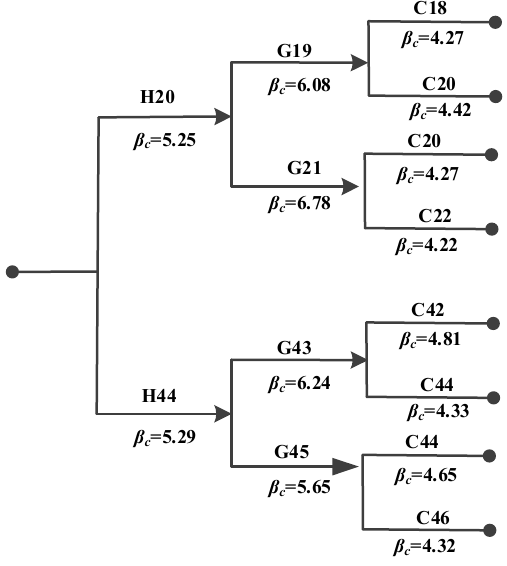
Figure 14. Fault tree of the suspension bridge.